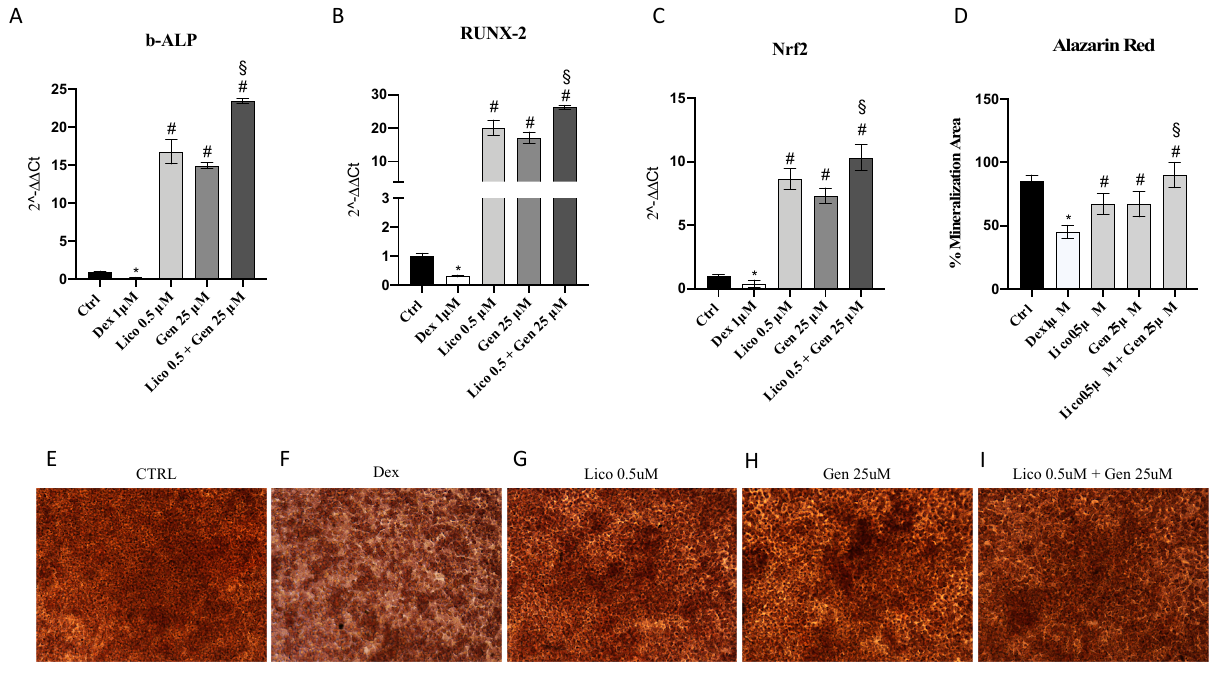
Figure 1. The graphs ( A – C ) represent b-ALP, RUNX-2, and NRF2 mRNA expression evaluated by q-PCR in primary osteoblasts treated with lycopene or genistein or lycopene and genistein following dexamethasone challenge for 24 h. The figures ( E – I ) show Alizarin Red S staining; primary osteoblasts incubated with dexamethasone for 24 h exhibit a reduction of mineralized matrix formation, demonstrated by the red color attenuation ( F ); cells treated with lycopene, genistein, and their association are characterized by a strong alizarin red accumulation, resulting from an increased mineralized matrix formation ( G – I ). Panel ( D ) shows the % of Mineralization Area evaluated in primary osteoblasts through Alizarin Red staining. The data are expressed as the means and SD. * p < 0.0001 vs. Ctrl; # p < 0.0001 vs. Dex; § p < 0.0001 vs lycopene and genistein. Alizarin Red S staining confirmed that DEX weakened mineralized matrix formation in osteoblasts, as observed by the red color attenuation (Figure 1F). Treatments with genistein or lycopene and especially the association of genistein and lycopene restored mineralization levels in treated cells (Figure